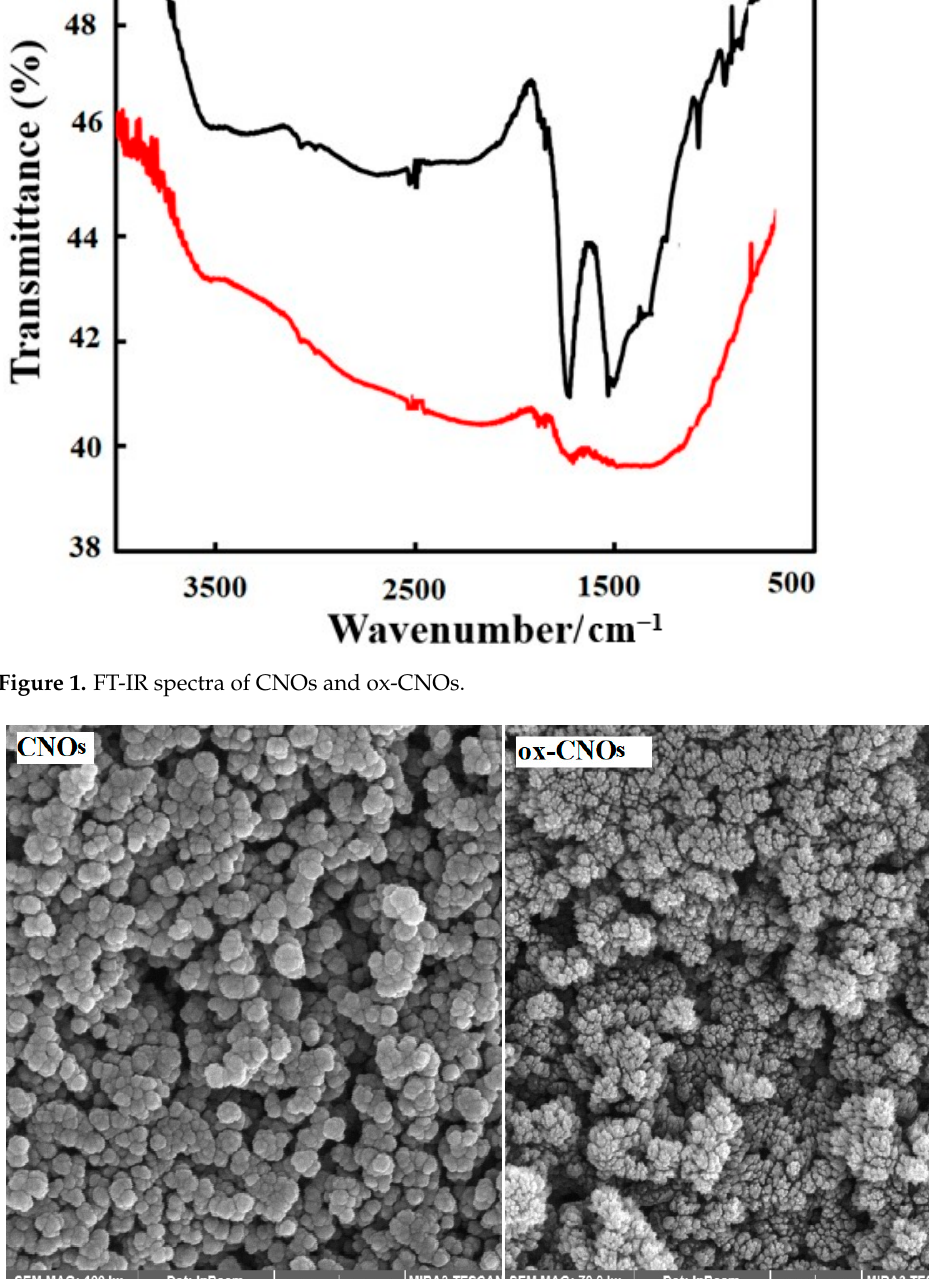
Figure 2. FE-SEM image of CNOs and ox-CNOs.